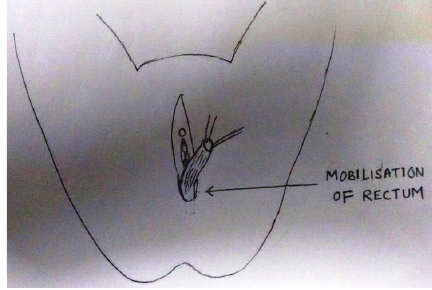
Figure 8: Mobilisation of rectum.